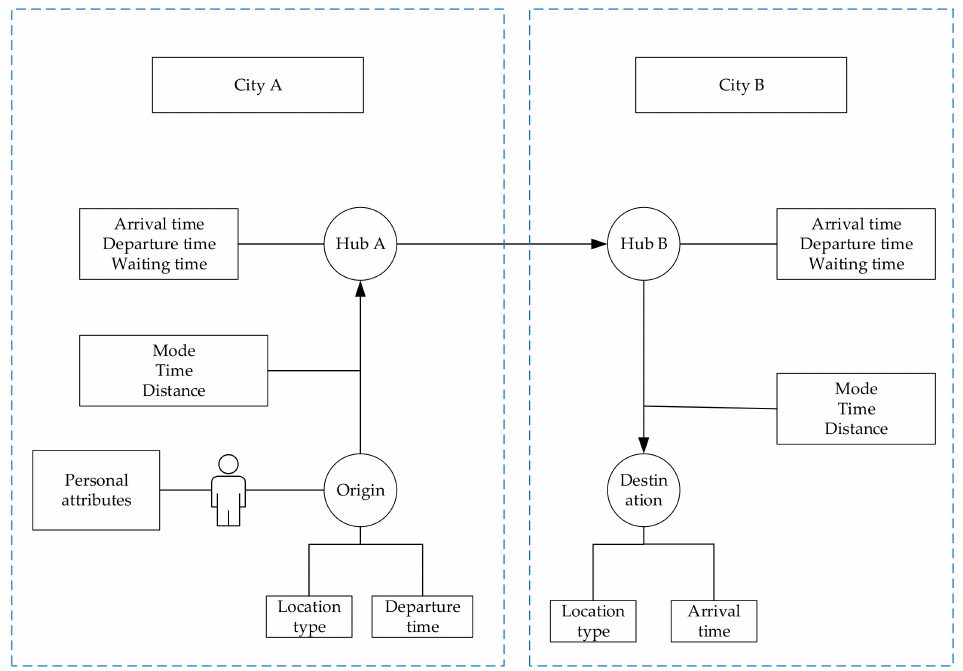
Figure 5. The process of generating individual trip